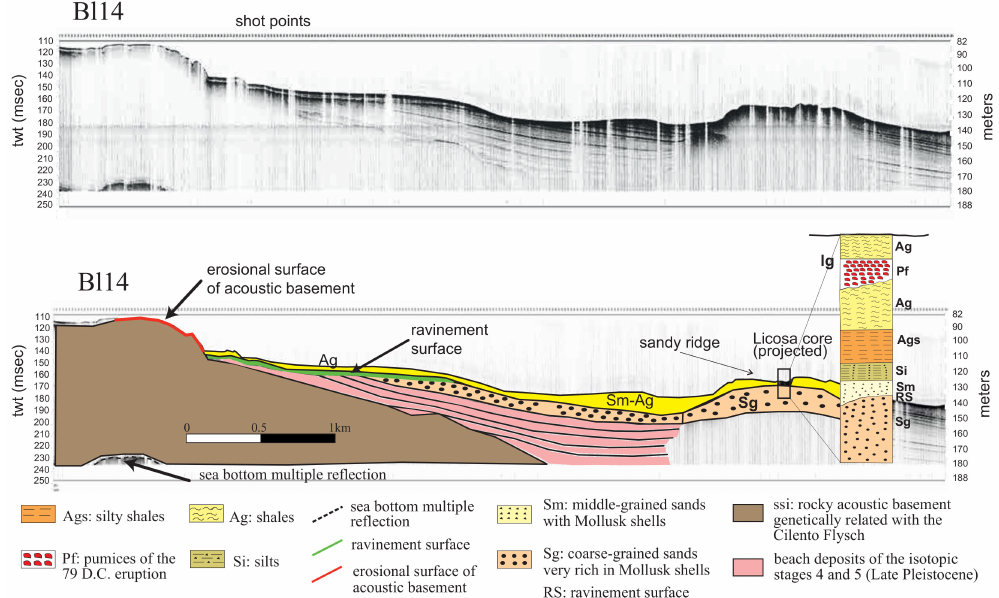
Figure 8. Sub-bottom profile Bl14 and corresponding geologic interpretation, calibrated with the lithostratigraphic data of the Licosa gravity core (see Figure 3 for location). The subfigure on the right side of the seismic profile represents the stratigraphy of the Licosa core (see the key to the seismic profile for the